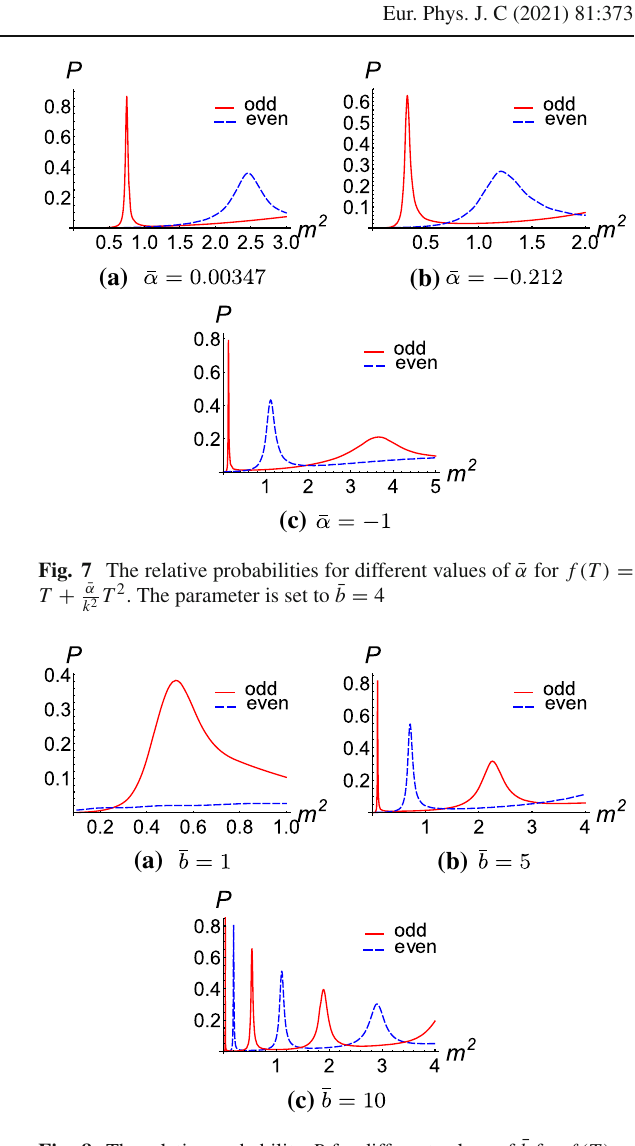
erties is due to the difference between f ( T ) = T + α T 2 and